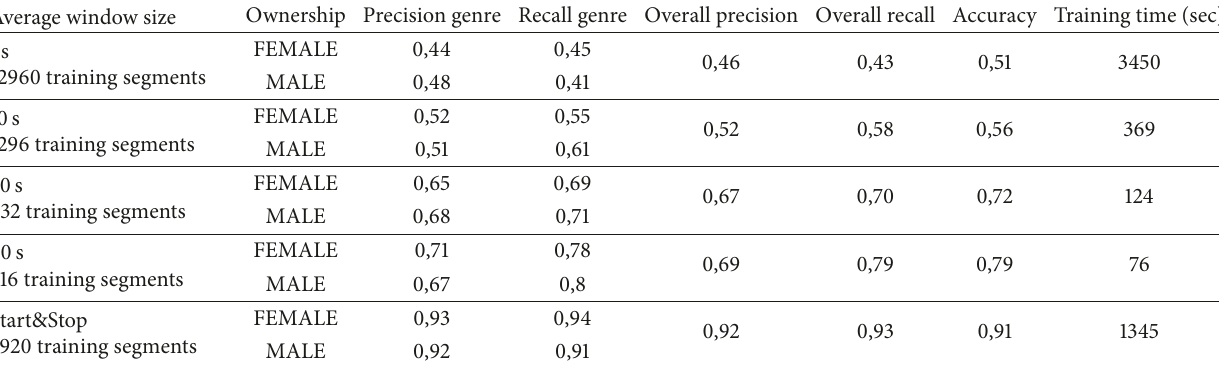
Table 8: 𝐸 15 , precision, recall, accuracy, and training time evaluated by using MLP for different windows sizes. Average window